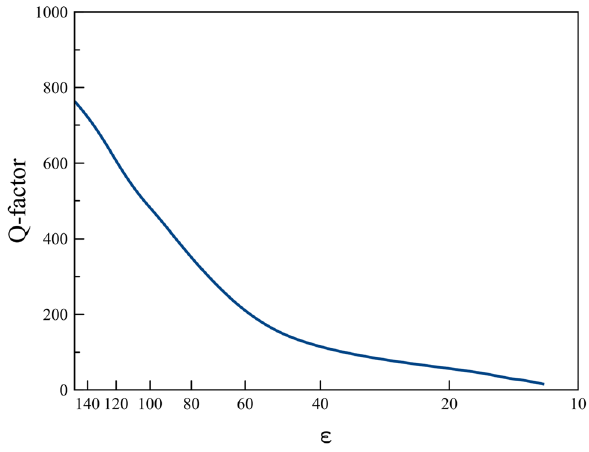
Figure 9. Dependence of dumbbell Kerker effect Q-factor on permittivity ε for spheroids of a/b = 1.56.